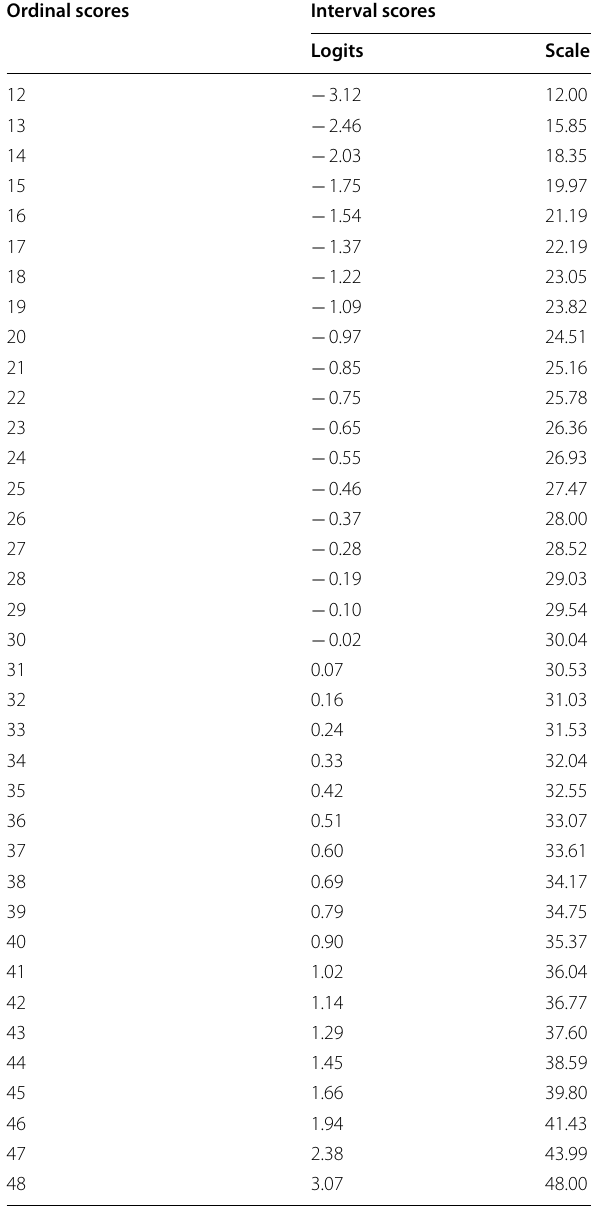
This table should not be used for individuals with one or more missing responses to the scale items